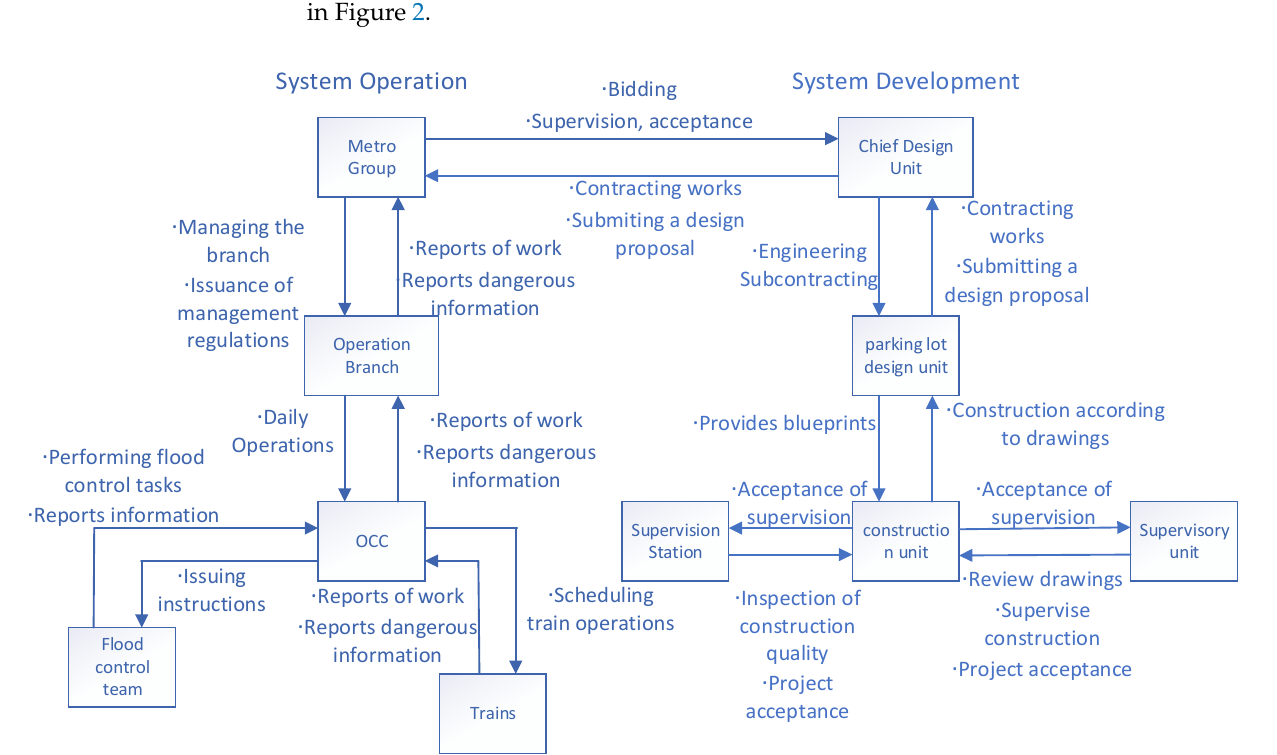
Figure 2. The security control structure for Zhengzhou Metro.